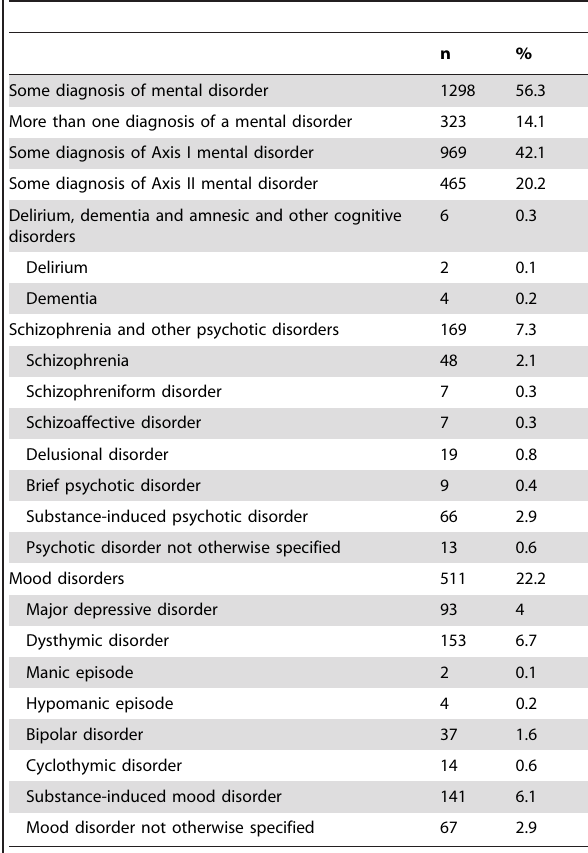
Table 2. Prevalence of mental disorders; cognitive, psychotic and mood